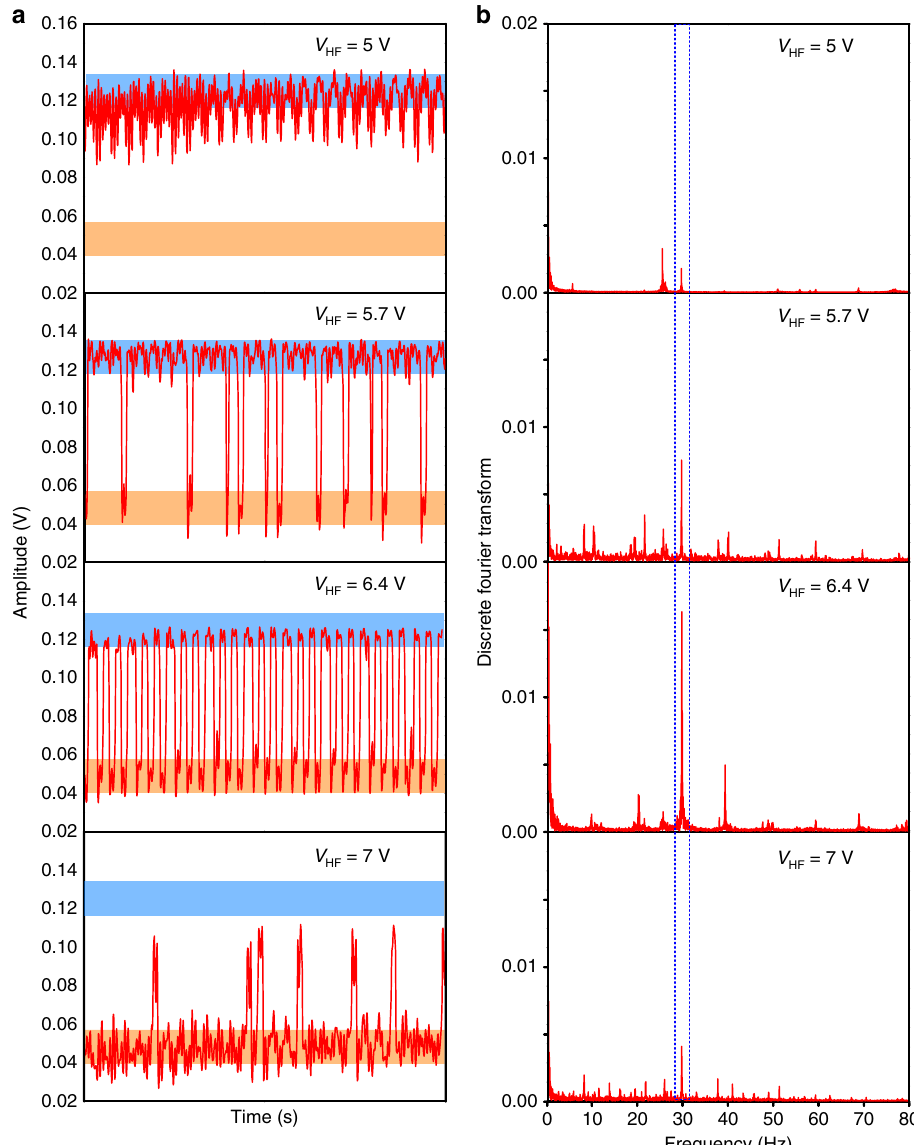
Fig. 2 Time responses and Discret Fourier Transform as function of high-frequency modulation. a Time series of the mechanical mode amplitude for a weak modulation with γ = 0.1, ν m = 30 Hz and for increasing high-frequency signal intensities V HF = 5 V , 5.7 V , 6.4 V and 7.0 V from top to bottom. The amplitudes of the two stable states at zero amplitude HF drive correspond to the blue and orange-shaded regions on each graph. b Discrete Fourier Transform of the time series displayed on the left. The vertical shaded lines enclose the modulation frequency ν m of the weak